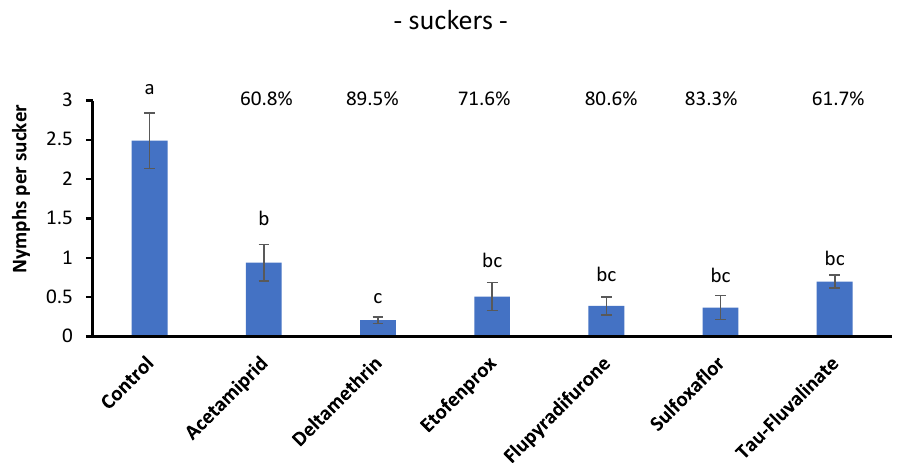
Figure 2. Effects of six insecticides on S. titanus nymphs (mean ± SE) evaluated at seven days from their application (FM vineyard). Different letters indicate significant differences at the t -test ( α = 0.05). For each insecticide the Henderson and Tilton efficacy (%) is also reported.